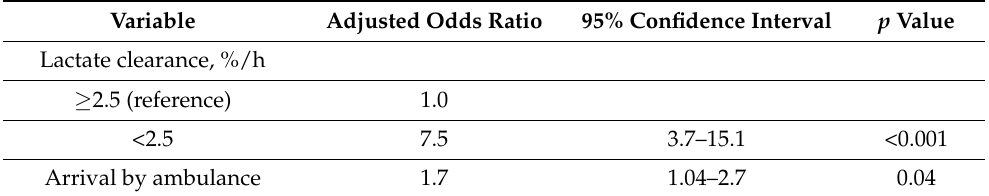
Table 5. Multivariable model of factors associated with emergency department-based in-hospital cardiac arrest among the subset of calculable lactate